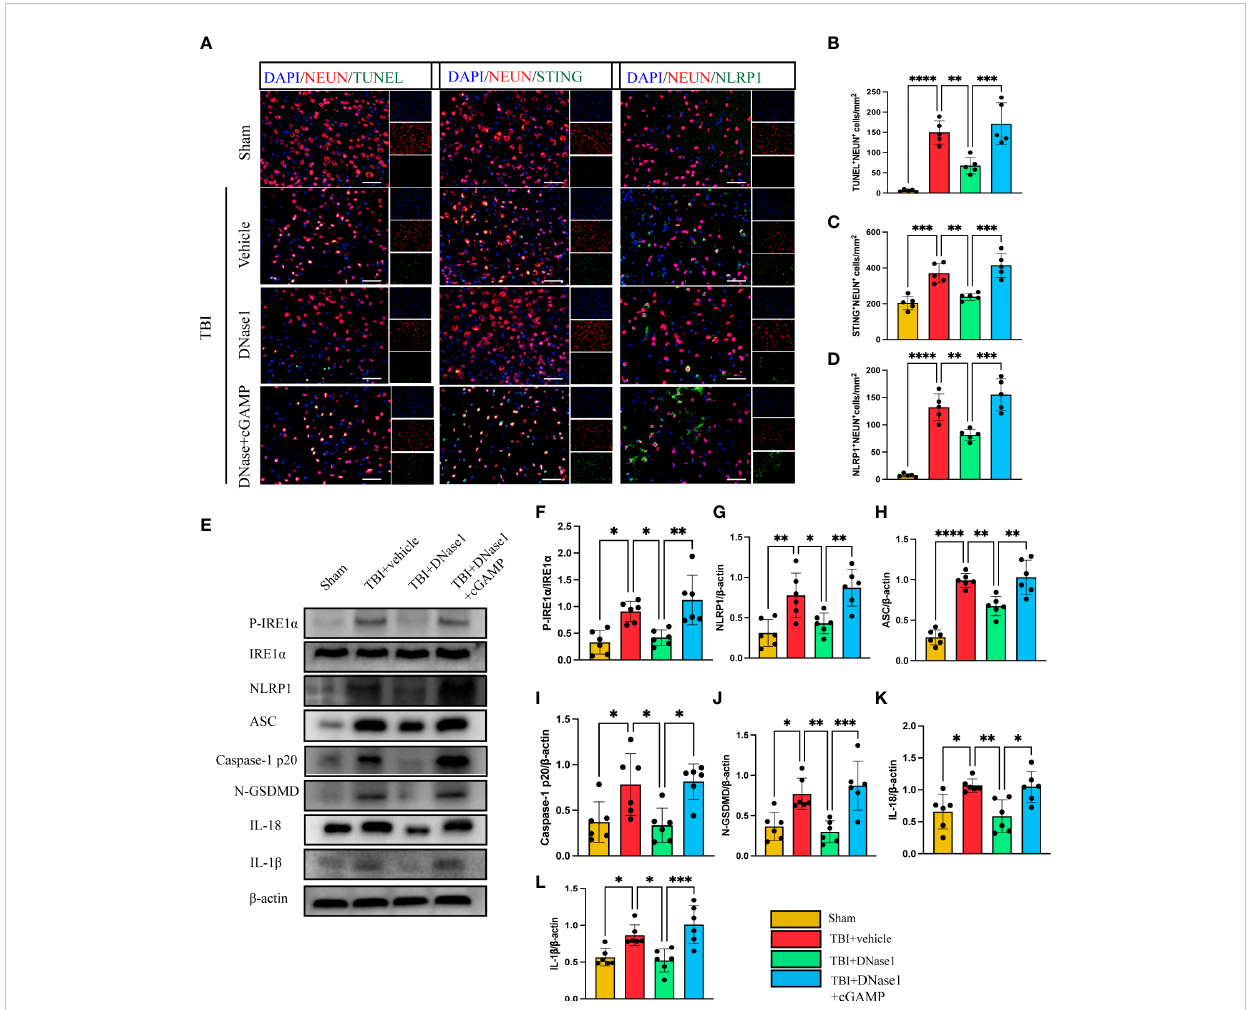
FIGURE 4 DNase 1 ameliorates neurons ’ pyroptosis by inhibiting the STING-IRE1 a -NLRP1 pathway after TBI. (A) Representative fl uorescent double stain images of NEUN-positive neurons with TUNEL-positive cells (green), STING-positive cells (green) and NLRP1-positive cells (green) in the peritraumatic cortex(n=5). Nuclei were stained with DAPI (blue). Scale bar = 50 m m. Count and analyze the number of double-stained positive cells of NEUN- positive neurons with TUNEL-positive cells (B) , STING-positive cells (C) and NLRP1-positive cells (D) . (E) Representative Western blot bands of P- IRE1 a , NLRP1, ASC, Caspase-1 p20, N-GSDMD, IL-18, IL-1 b and statistical analysis expression level of P-IRE1 a (F) , NLRP1 (G) , ASC (H) , Caspase-1